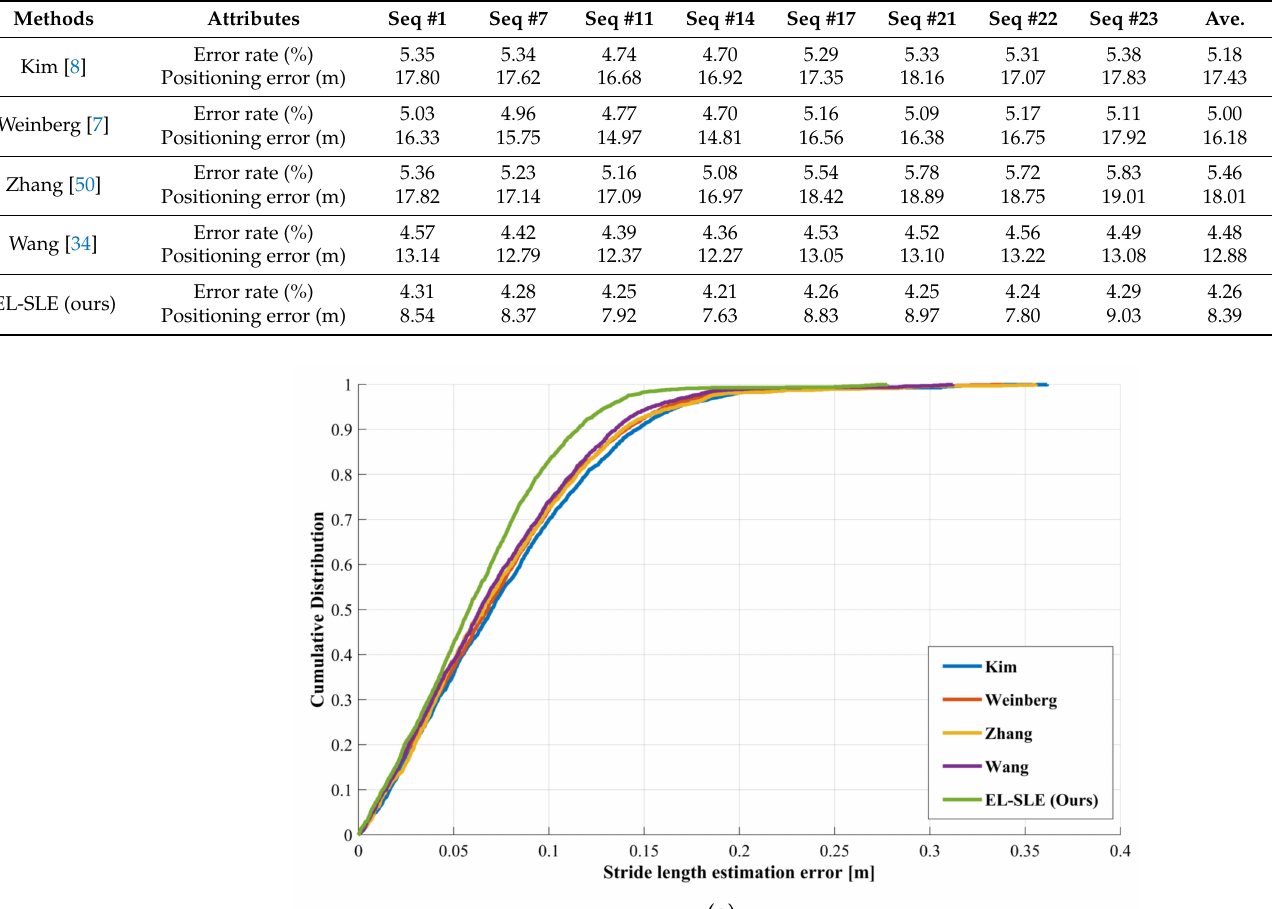
Table 7. Performance of stride-length estimation with different SLE models.